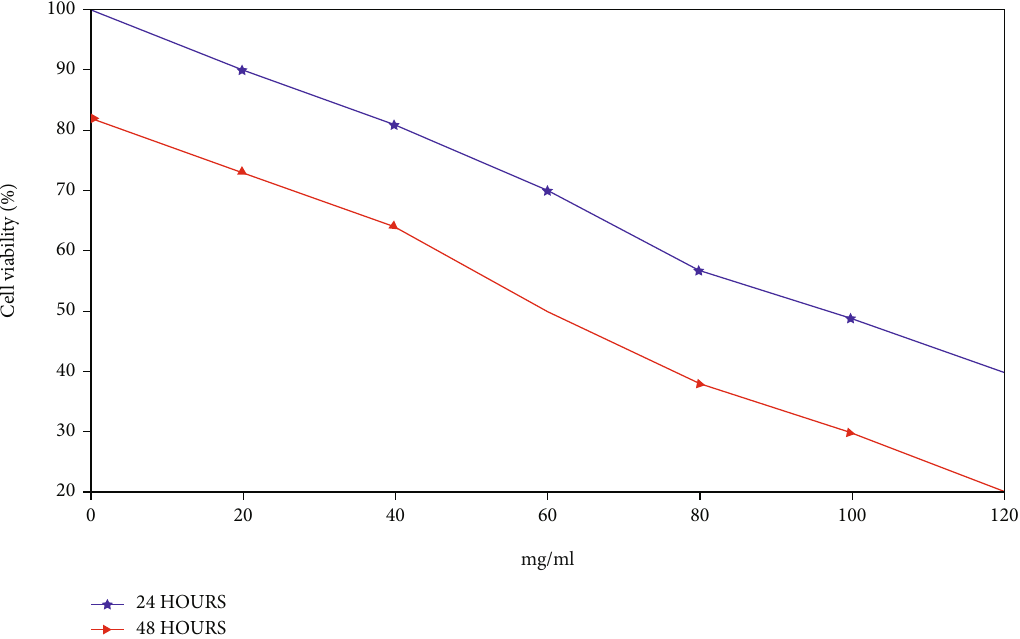
Figure 3: Cell viability vs. milligram per millilitre HQEZ-induced